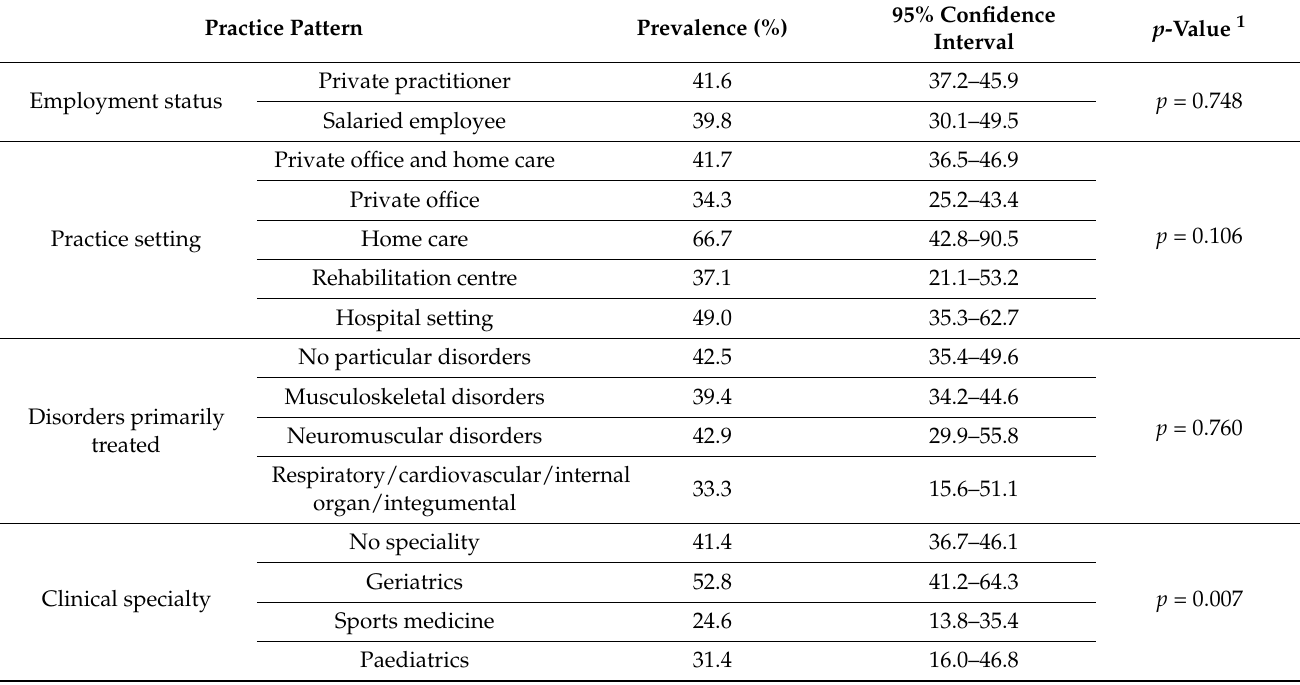
Table 2. Prevalences of work-related, non-specific lower back pain, as a function of practice